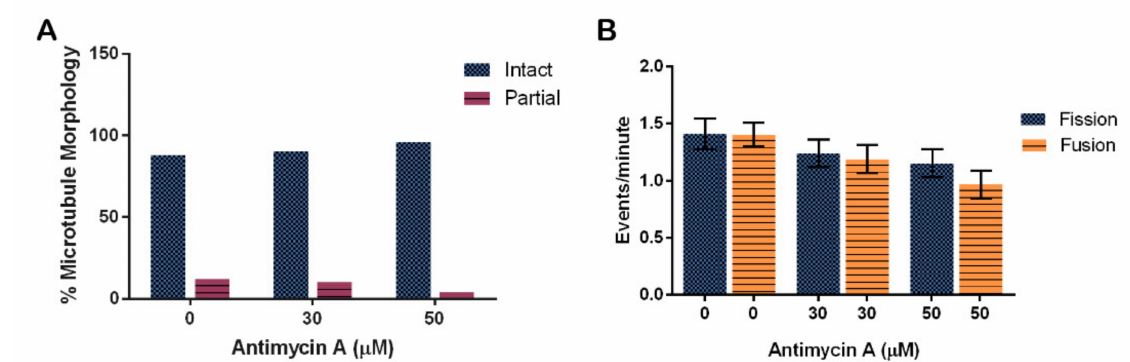
Figure 9. Effect of Antimycin A on microtubule morphology and mitochondrial fission and fusion in D. discoideum. ( A ) AMA did not significantly affect microtubule stability (n > 50 cells, p = 0.2846), nor ( B ) fission and fusion rates (n = 46 cells, p = 0.0516), though these rates trend faster with less AMA. Columns are averages and error bars represent the standard